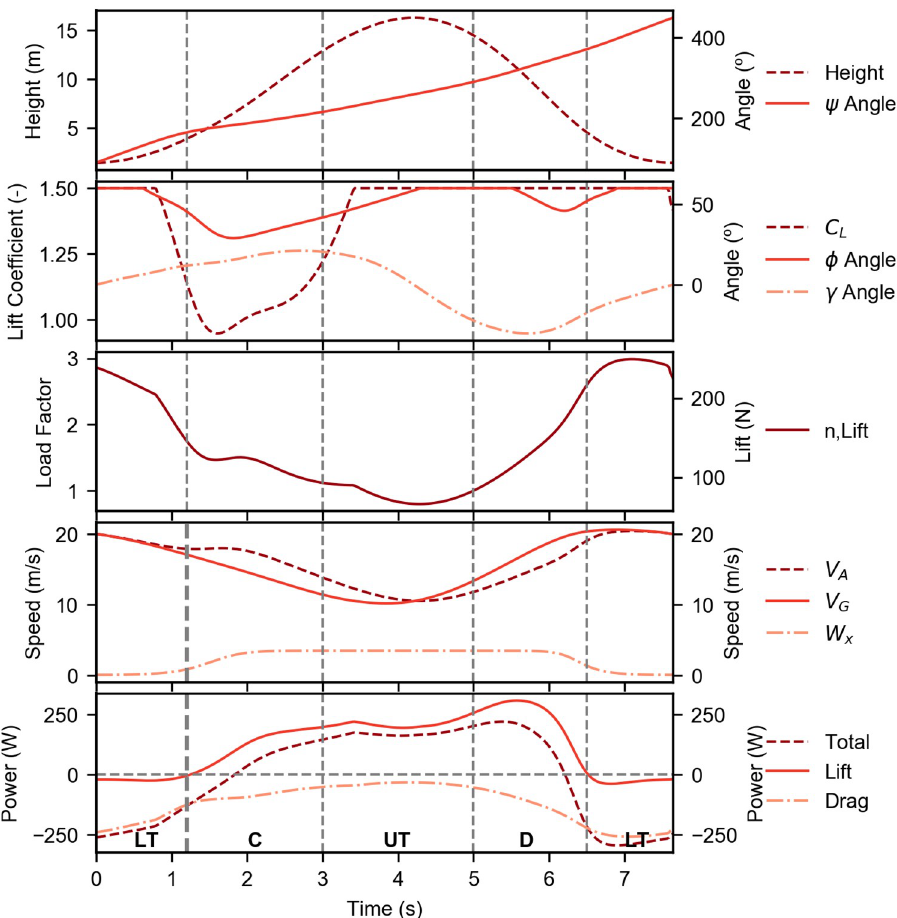
Fig 9. Evolution of the Rayleigh cycle. Detailed time evolution of the main parameters of the optimal trajectory that minimizes the wind strength required for a step wind profile ( k = 0.5, b = 0.5). The first panel presents the altitude and heading angle. The second panel presents the control variables and the flight path angle. The third panel presents the lift and load factor (the lines are coincident). The fourth panel presents the ground speed, airspeed and wind speed. Finally, the last panel presents the lift and drag contributions for the variation of the mechanical energy, as well as the overall variation of the energy (LT—Lower Turn, C—Climb, UT—Upper Turn, D—Descent).